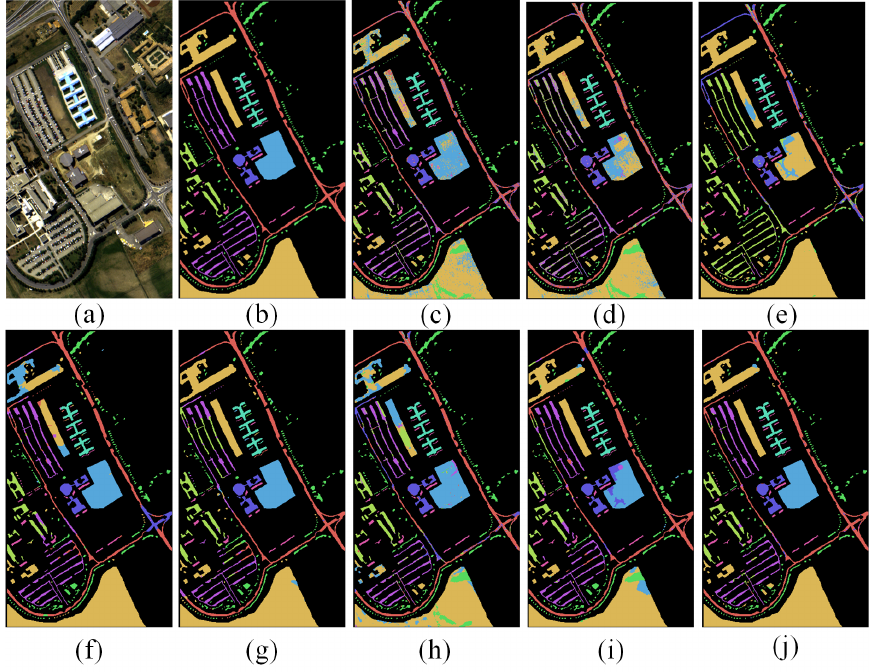
Figure 8. Classification maps of different methods on University of Pavia dataset; ( a ) Composite RGB image. ( b ) Groundtruth map. ( c ) SVM; ( d ) 3D-CNN; ( e ) 1D+2D; ( f ) GCN-M; ( g ) KDCDWBF; ( h ) STSE_DWLR; ( i ) SGL; ( j ) MSGLAMS